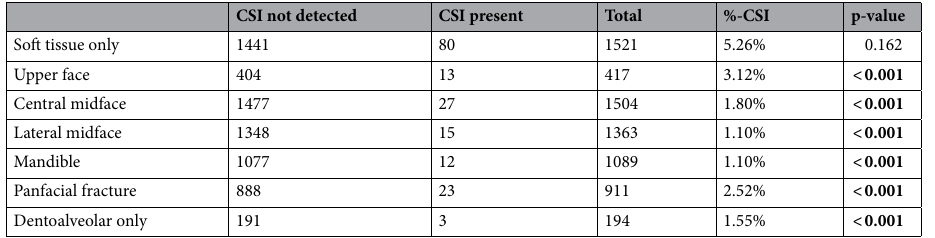
Table 2. Patient distribution with different MFI with reference to the absolute numbers and ratio of CSI in each group. Significant p-values are typed in bold ( χ 2 -test, confidence interval: p < 0.05). P-values represent the p-values of χ 2 -test analyzing the difference between the two groups (confidence interval: p = 0.05).